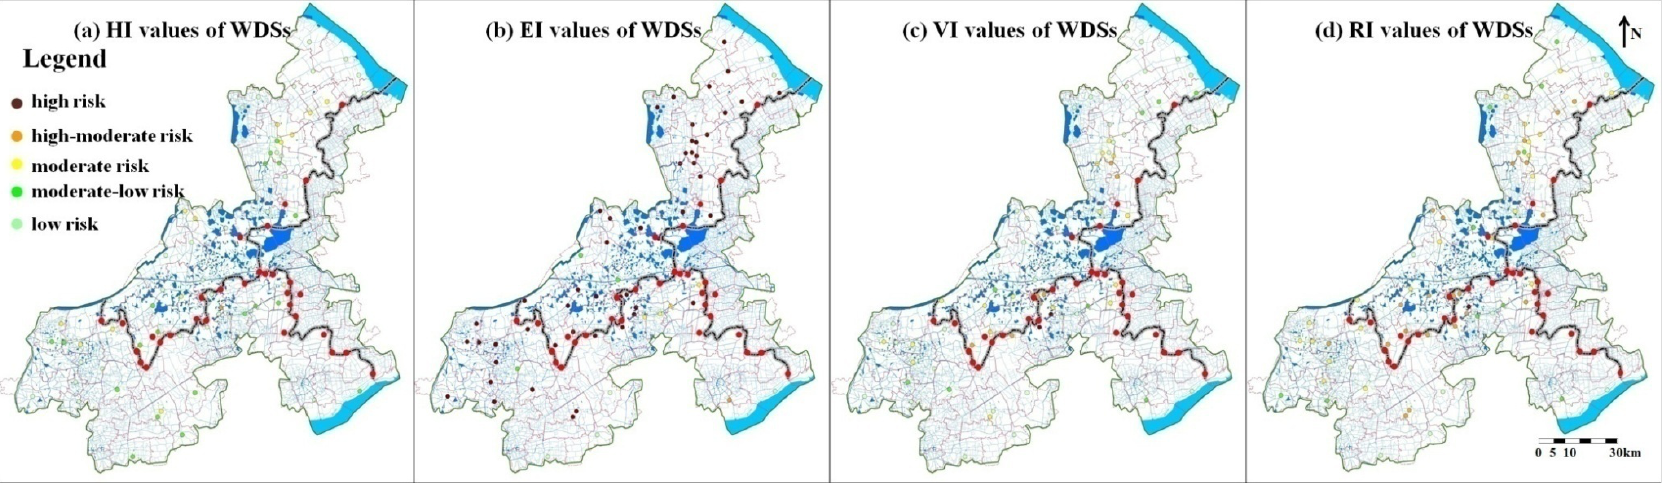
Figure 7. Spatial distribution of HI, EI, VI and RI values of the